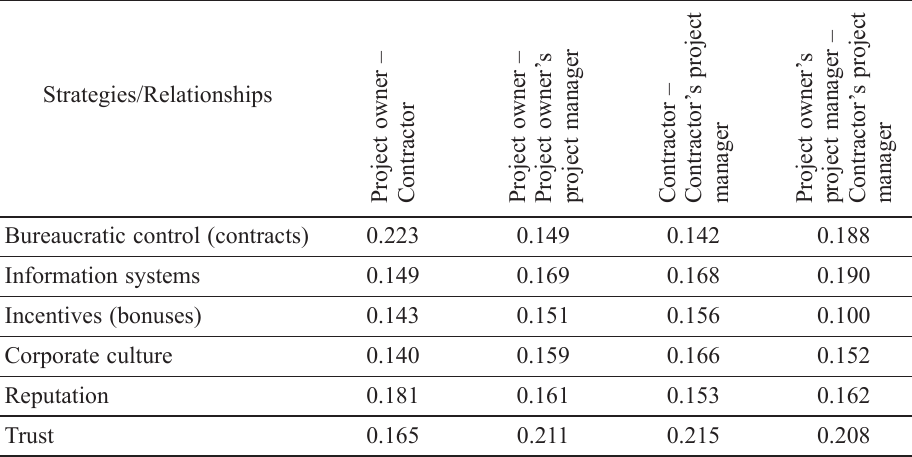
Table 3. Utility function values for risk-minimization strategies